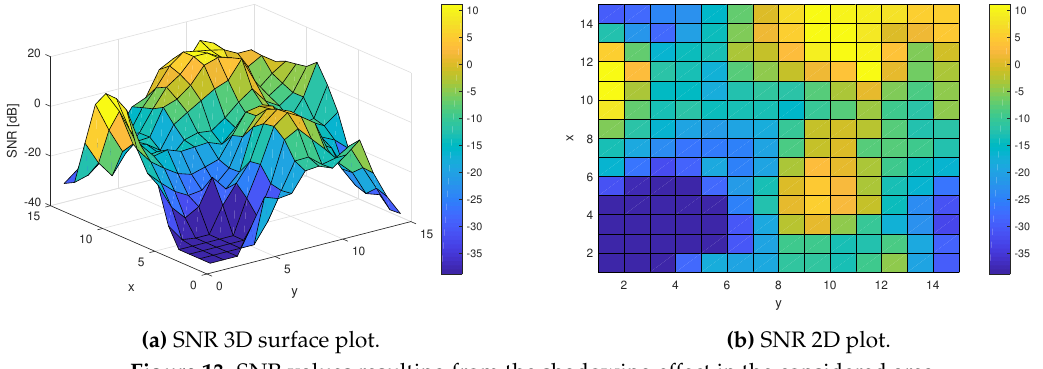
Figure 13. SNR values resulting from the shadowing effect in the considered area.